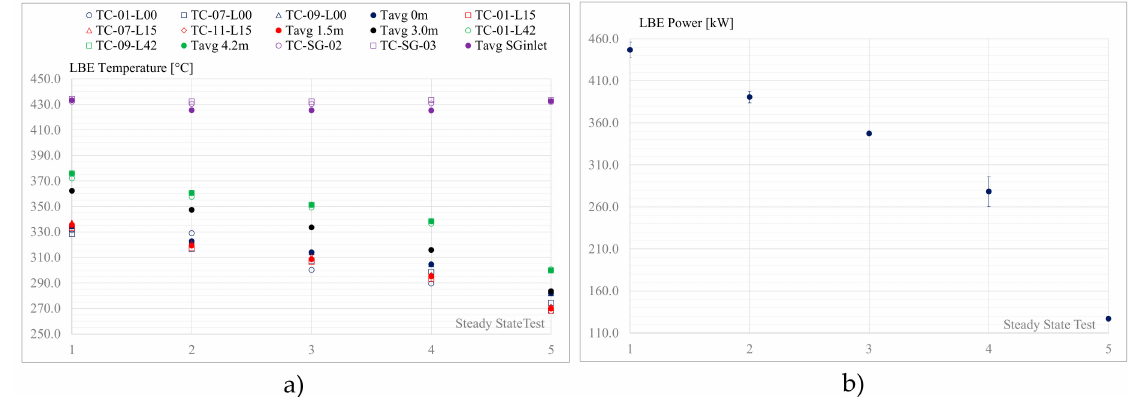
Figure 8. EF-T4: ( a ) LBE temperatures along the SG shell side for all the steady states; ( b ) LBE power and relative standard deviation at steady states.